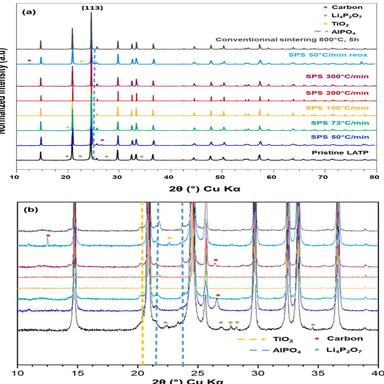
XRD patterns of the pristine LATP powder, the samples sintered by SPS using heating rates ranging from 50 ◦C/min to 300 ◦C/min, the re-oxidized sample and the conventional sintered sample (a). A zoom of the background was done in order to highlight the presence of impurities, some of them (not marked) being not identified (b).